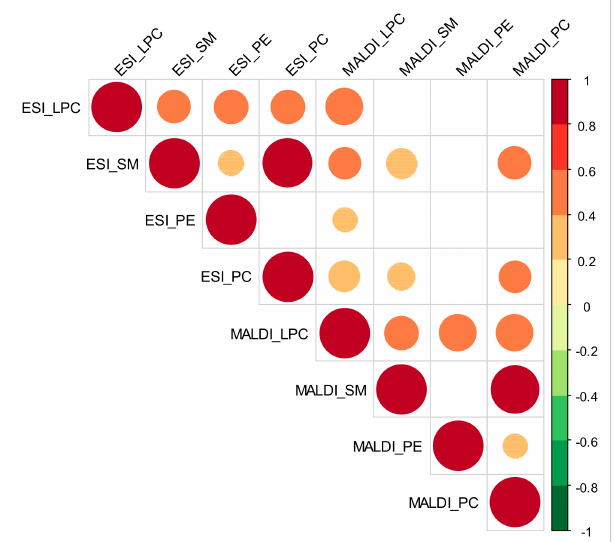
Figure 4. Correlation matrix built on the data using total response of phospholipids, in the case of data acquired from both techniques (MALDI: MALDI-ToF/MS analysis, ESI: ESI-QqQ/MS analysis). Color code refers to rho coefficient; the size of circles is proportional to the strength of correlations; blank cells correspond to nonsignificant bicorrelations ( p > 0.05).